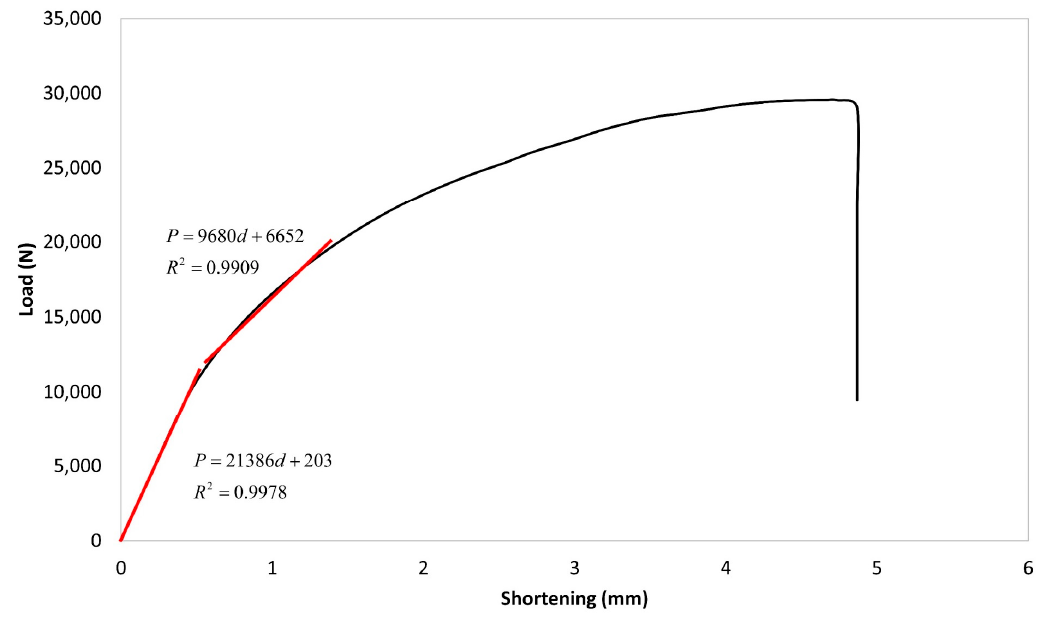
Figure 10. Critical buckling load determination of the current study FEM result (0.1 h imperfection amplitude).